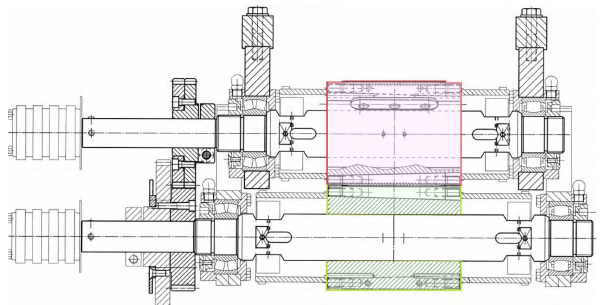
Figure 3. Rotating heads.